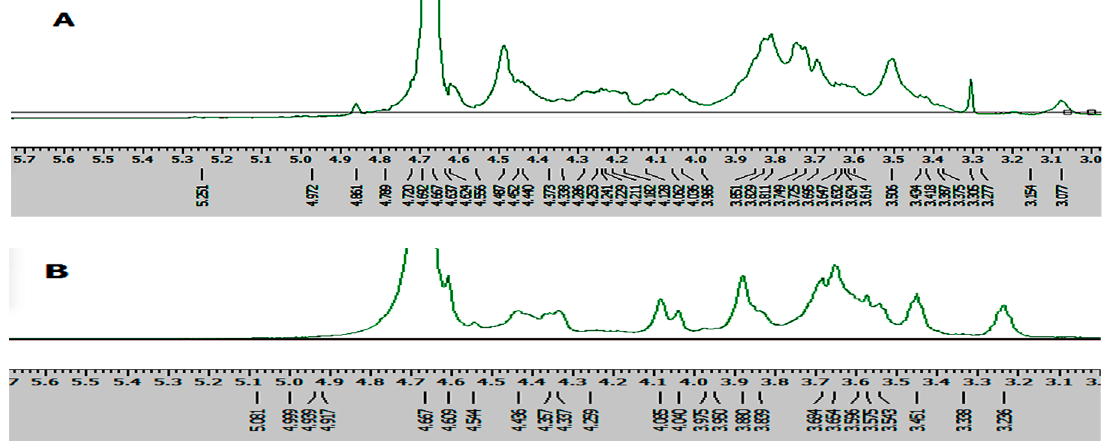
Figure 5. 1 H-NMR spectra of ( A ) IOEP1 and ( B ) IOEP2.